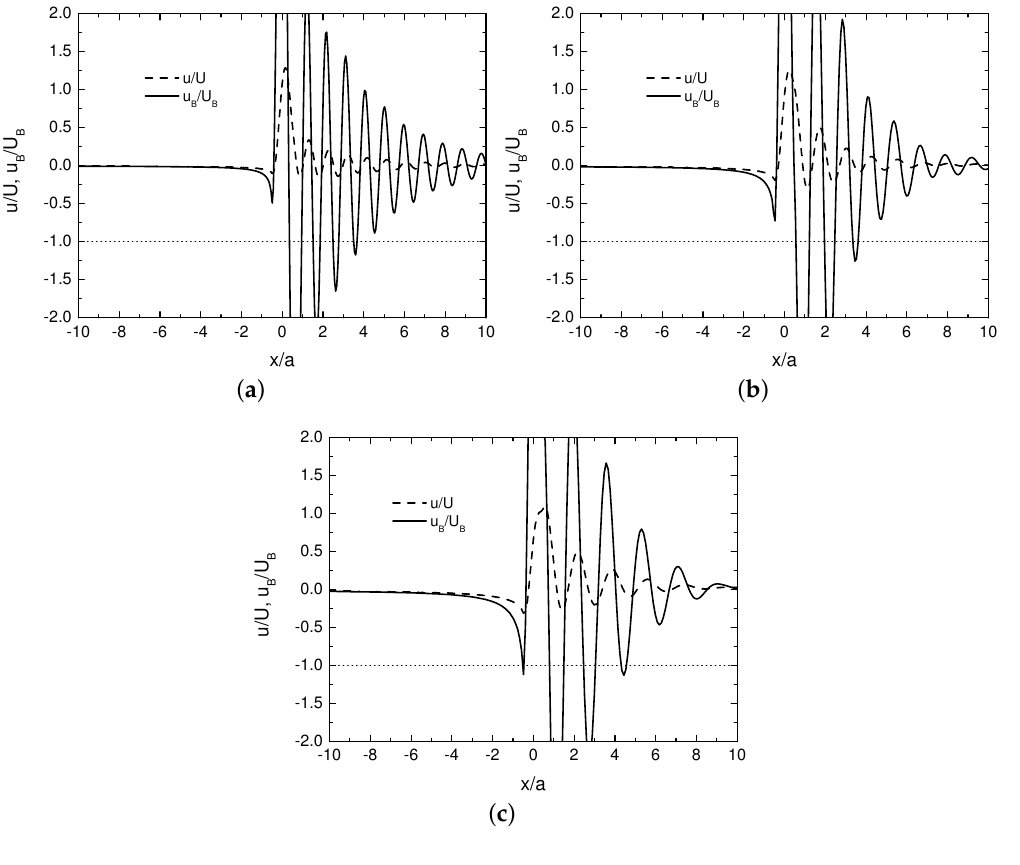
Figure 6. Similar to Figure 5, except that ( a ) Fr = 0.7, ( l 2 H ) − 1 = 2; ( b ) Fr = 0.8, ( l 2 H ) − 1 = 2; ( c ) Fr = 0.9, ( l 2 H ) − 1 =